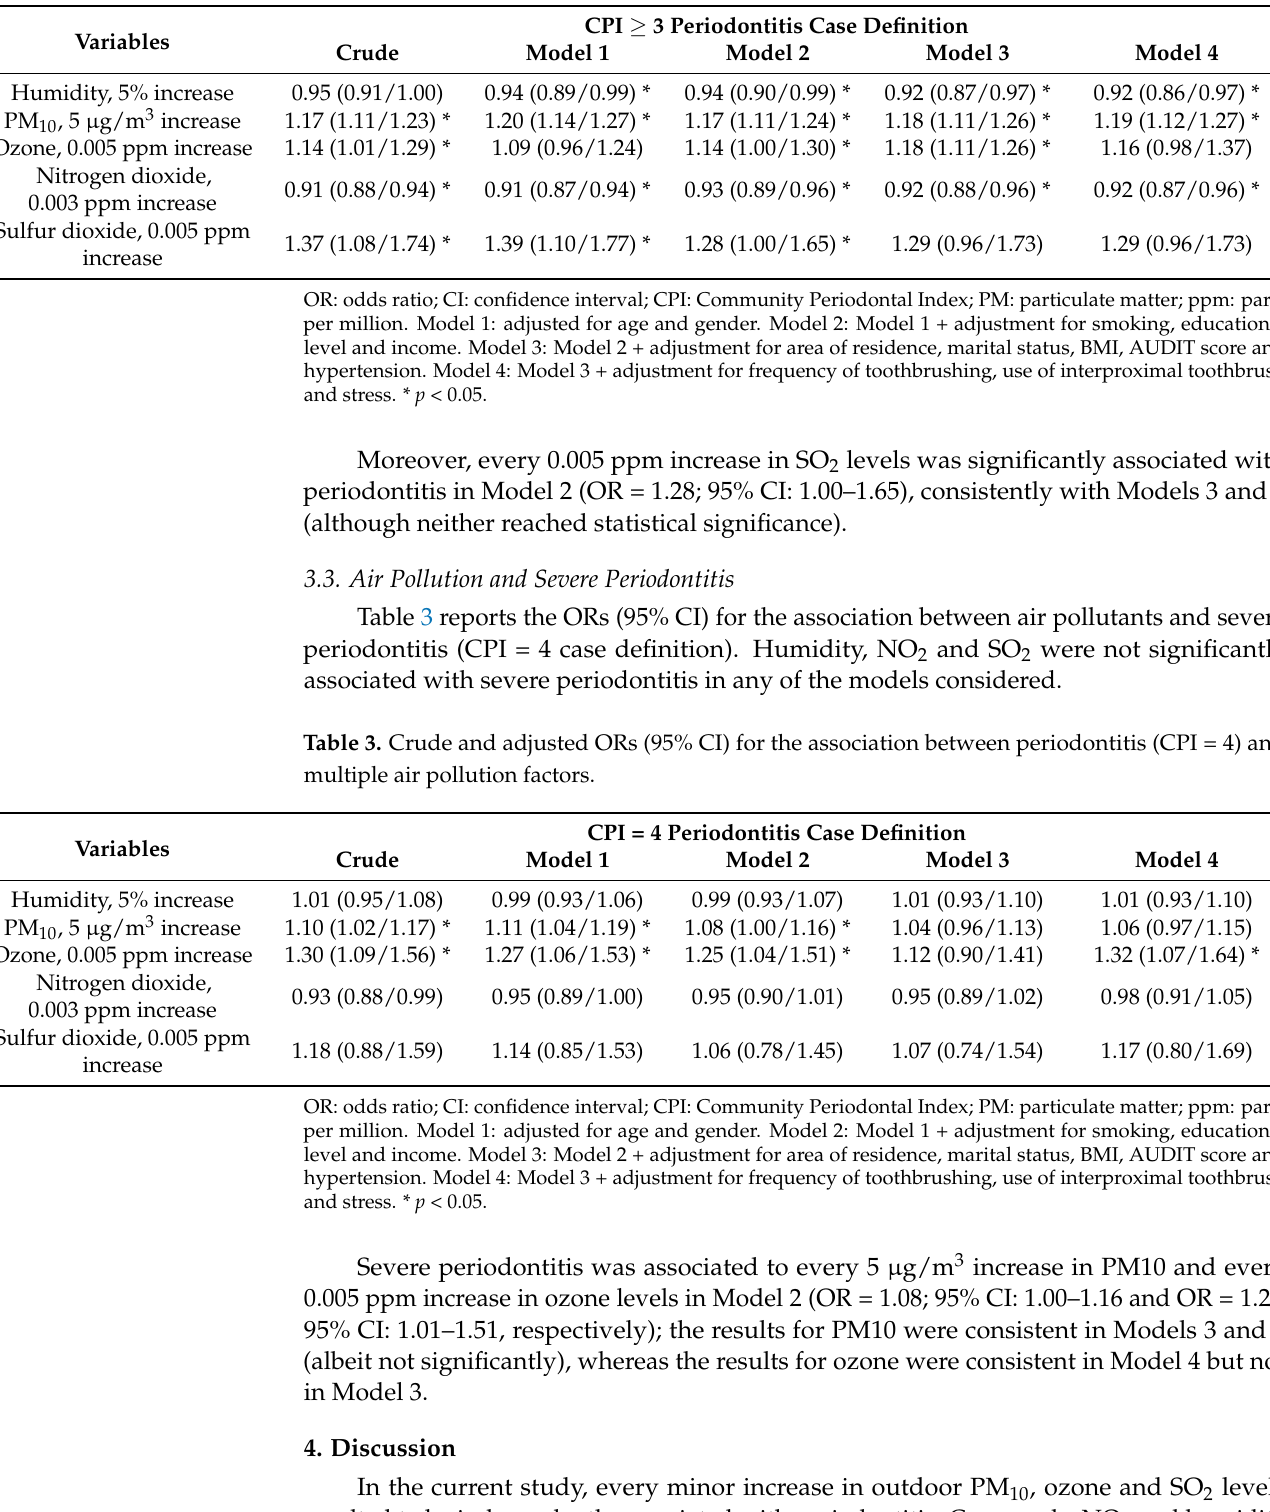
Table 2. Crude and adjusted ORs (95% CI) for the association between periodontitis (CPI ≥ 3) and multiple air pollution factors.